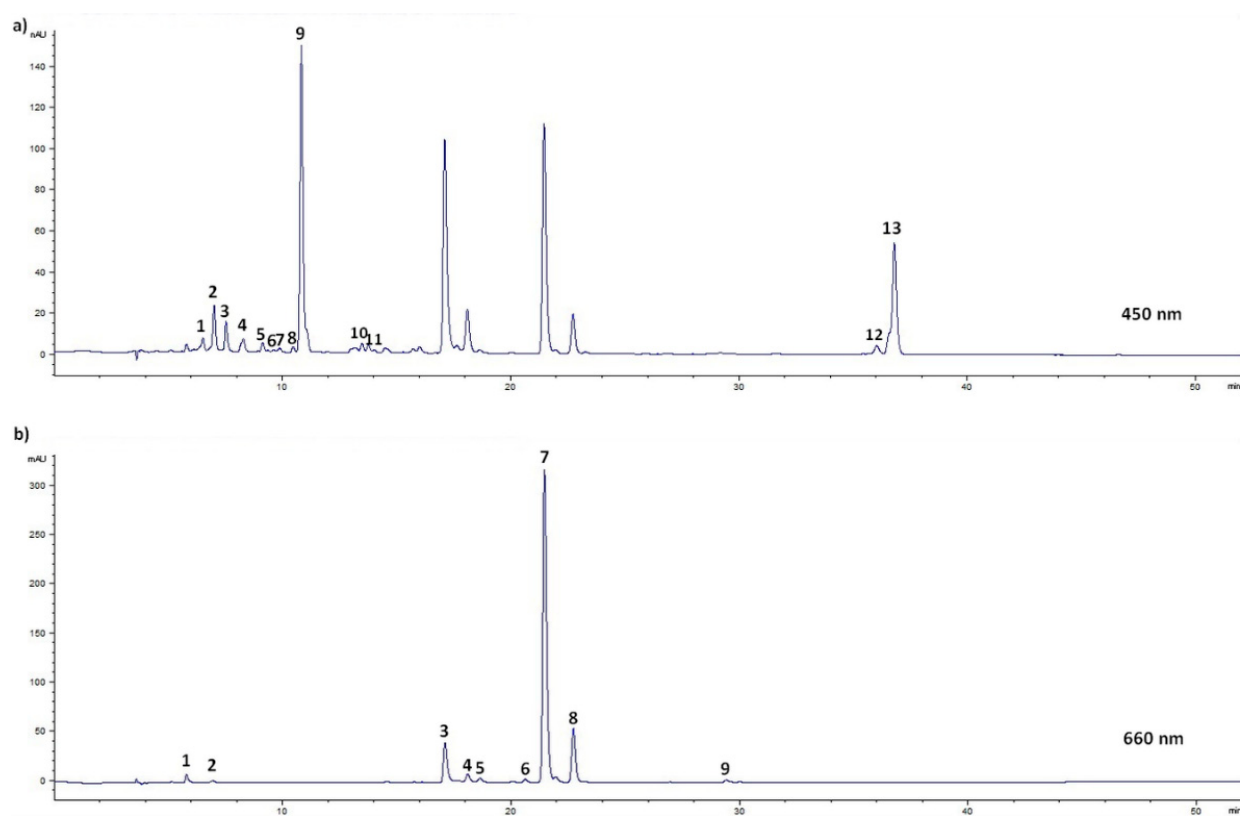
Figure 1. HPLC UV-VIS/PDA detection of pigments in wild nettle leaves ( Urtica dioica L.) collected from Pore č before flowering: a) at 450 nm (1 = violaxanthin derivative 1, 2 = neoxanthin derivative 1, 3 = neoxanthin, 4 = violaxanthin, 5 = violaxanthin derivative 2, 6 = 13 ′ - cis -lutein, 7 = neoxanthin derivative 2, 8 = lutein 5,6-epoxide, 9 = lutein, 10 = zeaxanthin, 11 = 9 ′ - cis -lutein, 12 = α -carotene, 13 = β -carotene); b) at 660 nm (1 = chlorophyll a derivative 1, 2 = chlorophyll a derivative 2, 3 = chlorophyll b , 4 = chlorophyll b derivative 1, 5 = chlorophyll a derivative 3, 6 = chlorophyll a derivative 4, 7 = chlorophyll a , 8 = chlorophyll a derivative 5, 9 = chlorophyll a derivative 6).